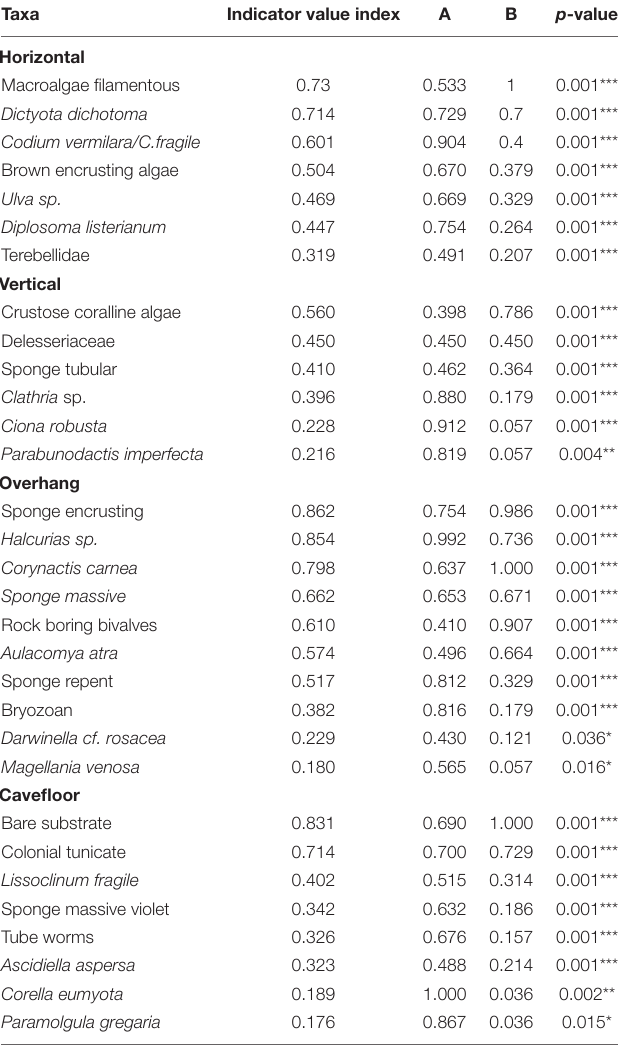
TABLE 3 | Indicator value indices for each surface orientation within all depth.